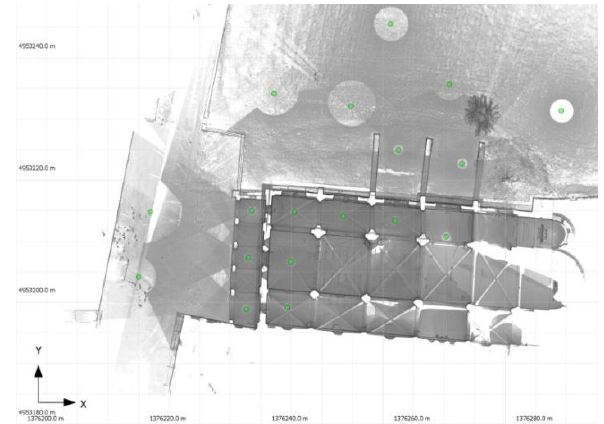
Figure 2. Nadiral view of the point clouds acquired by laser scanner. Green cue-balls mark the scans positions.